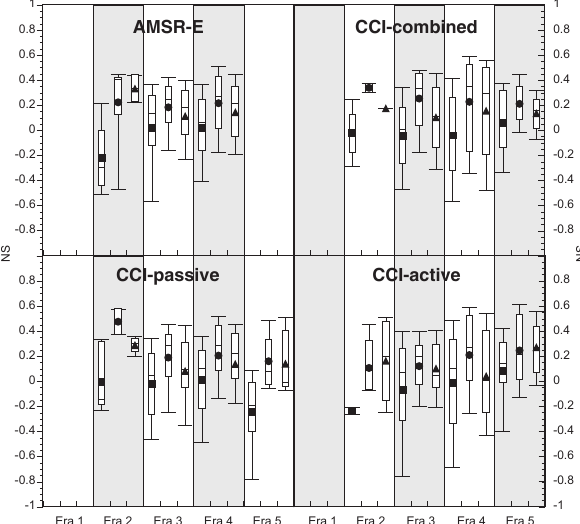
Figure 8. Box plots depicting the RMSE metric for the SCAN net- work. Symbols are the same as in Fig. 4.